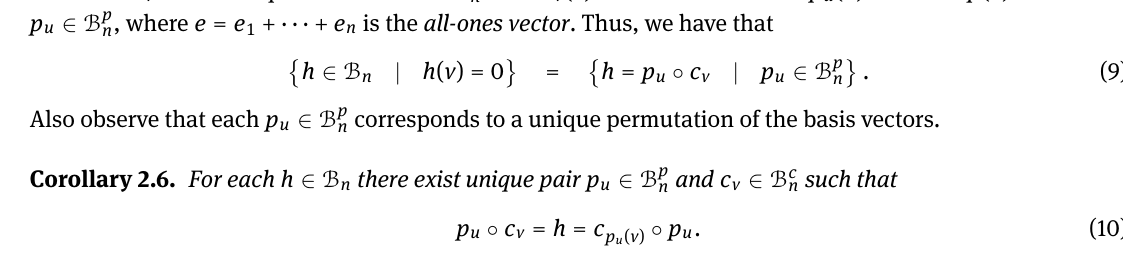
and B p , let for instance w = (0, 1, 1) (cid:62) . Then c 3